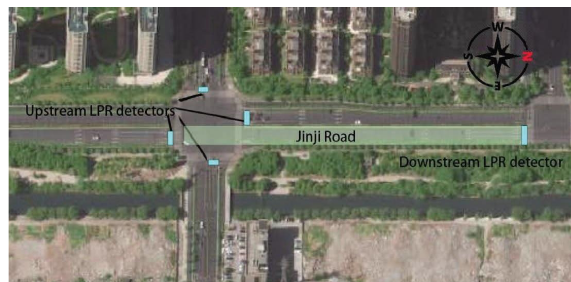
Figure 3: Detectors’ location in Jinji road.